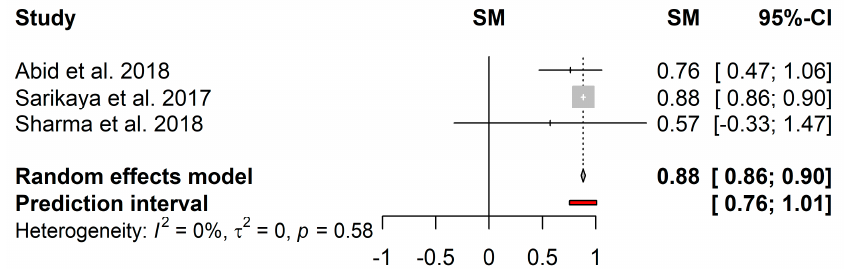
Figure 6. Forest plot of the pooled effect estimates for the proportion of biofilm reduction induced by EPS. The vertical dashes represent the effect estimate, and the horizontal line is the respective confidence interval at 95% (95%–CI) obtained for each study. Gray squares represent the standard deviation of each study, while the gray diamond represents the pooled effect estimates. The red bar represents the predictive interval. Heterogeneity test: I 2 – I 2 test; τ 2 –Tau-squared test.